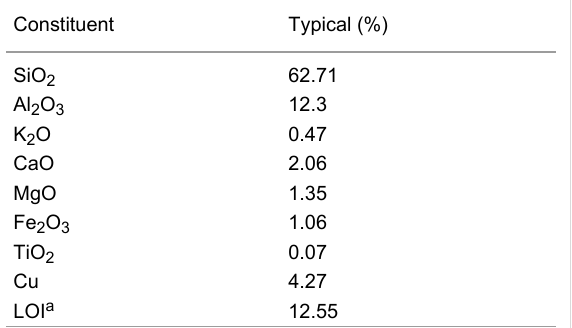
Table 1: Typical approximate compositional analysis of Cu NPs/